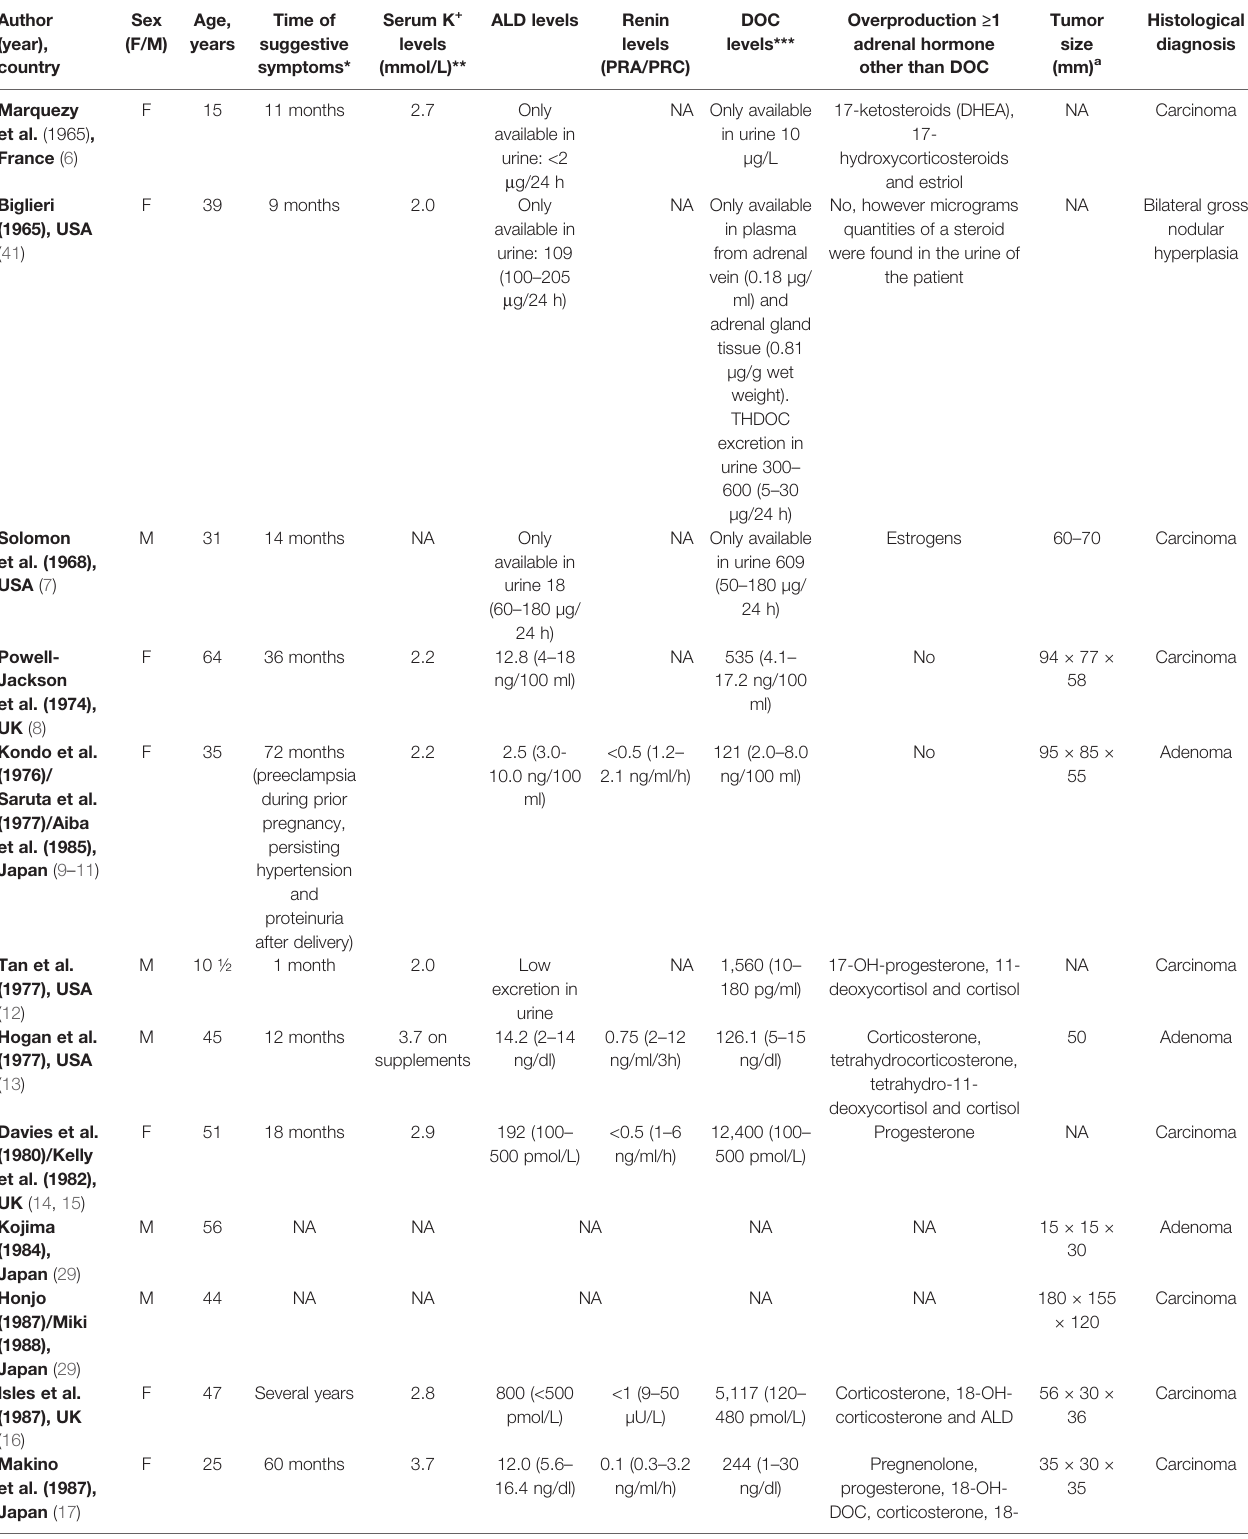
TABLE 2 | Clinical characteristics and biochemical, imaging and histological fi ndings of DOC-producing adrenal tumors or hyperplasia. Literature review and report of a new case. Author